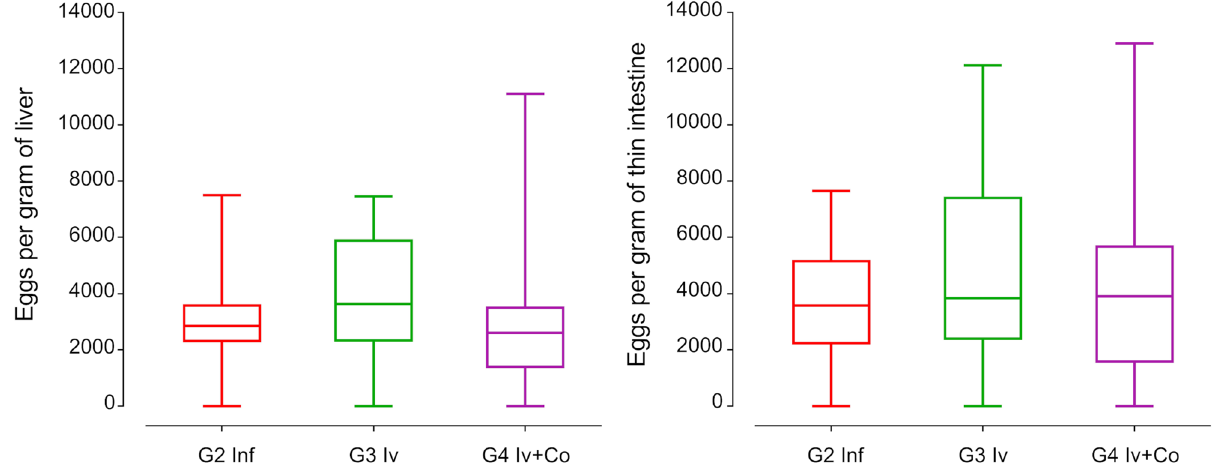
Figure 4. Eggs per gram of liver or thin intestine at the necropsy eight weeks post-infection of mice treated with ivermectin (Iv) or ivermectin and cobicistat (Iv + Co), infected with 150 cercariae of S. mansoni (inf).